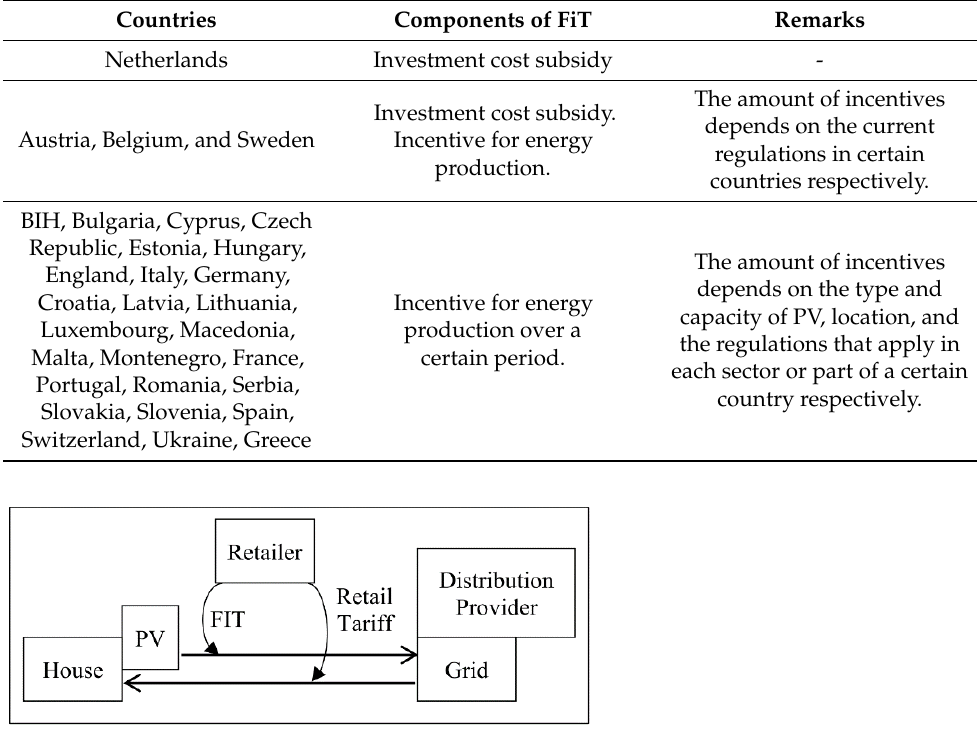
Figure 2. Gross metering measurement method [11].